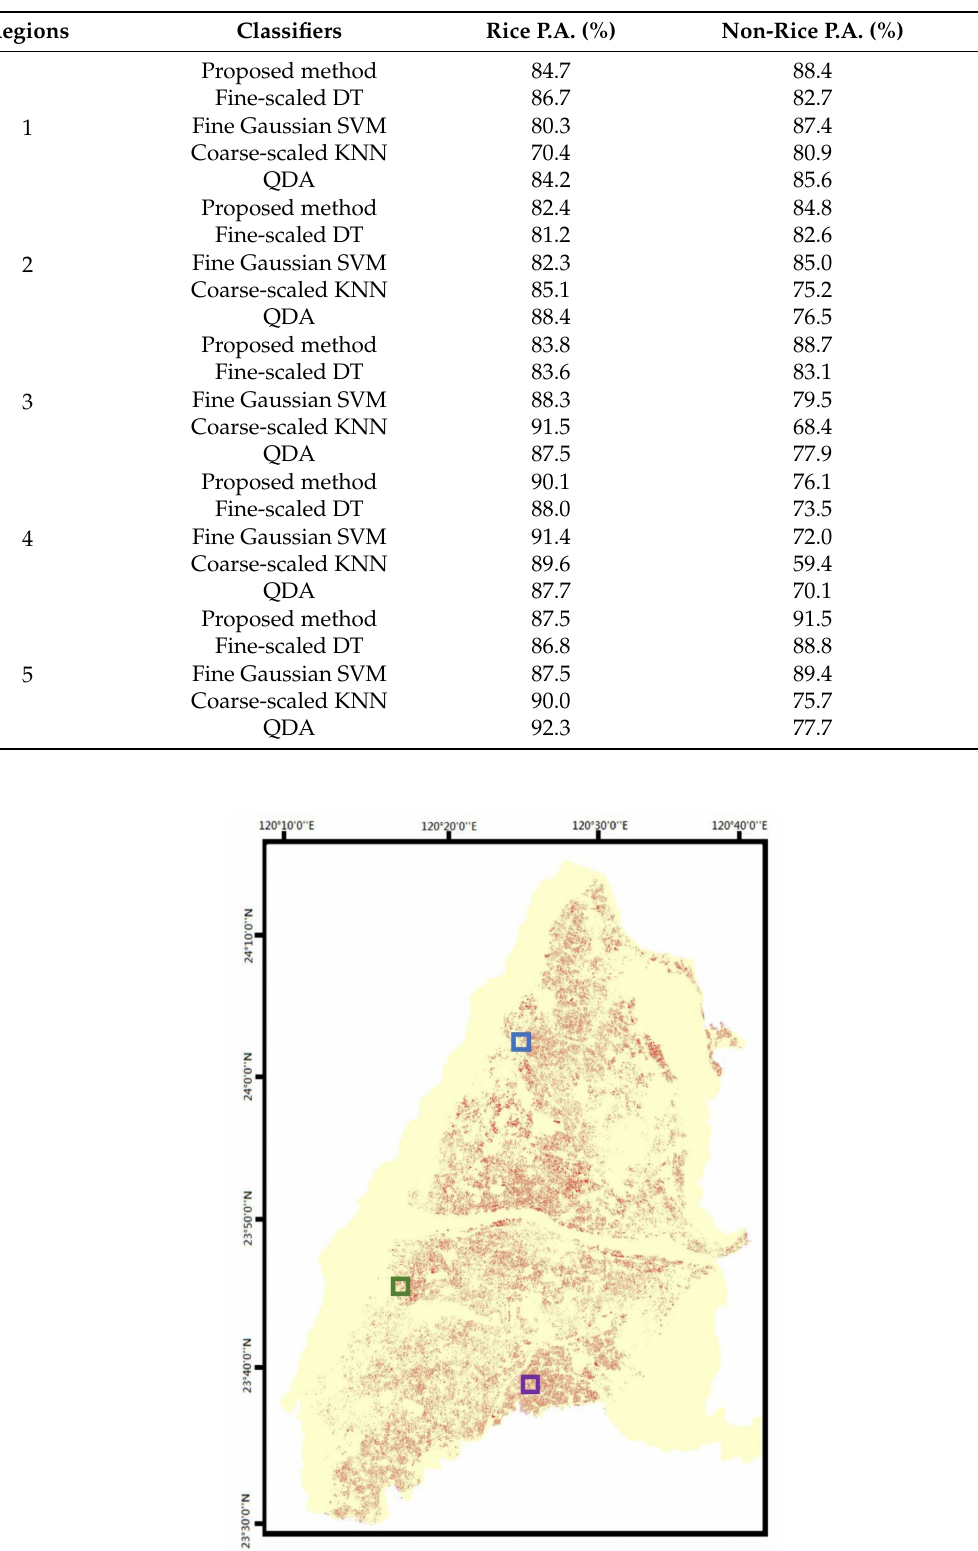
Figure 11. The rice-field mapping of the study area. The yellow color is the study area and the rice pixels are shown in red. The blue, green and purple squares represent the three selected